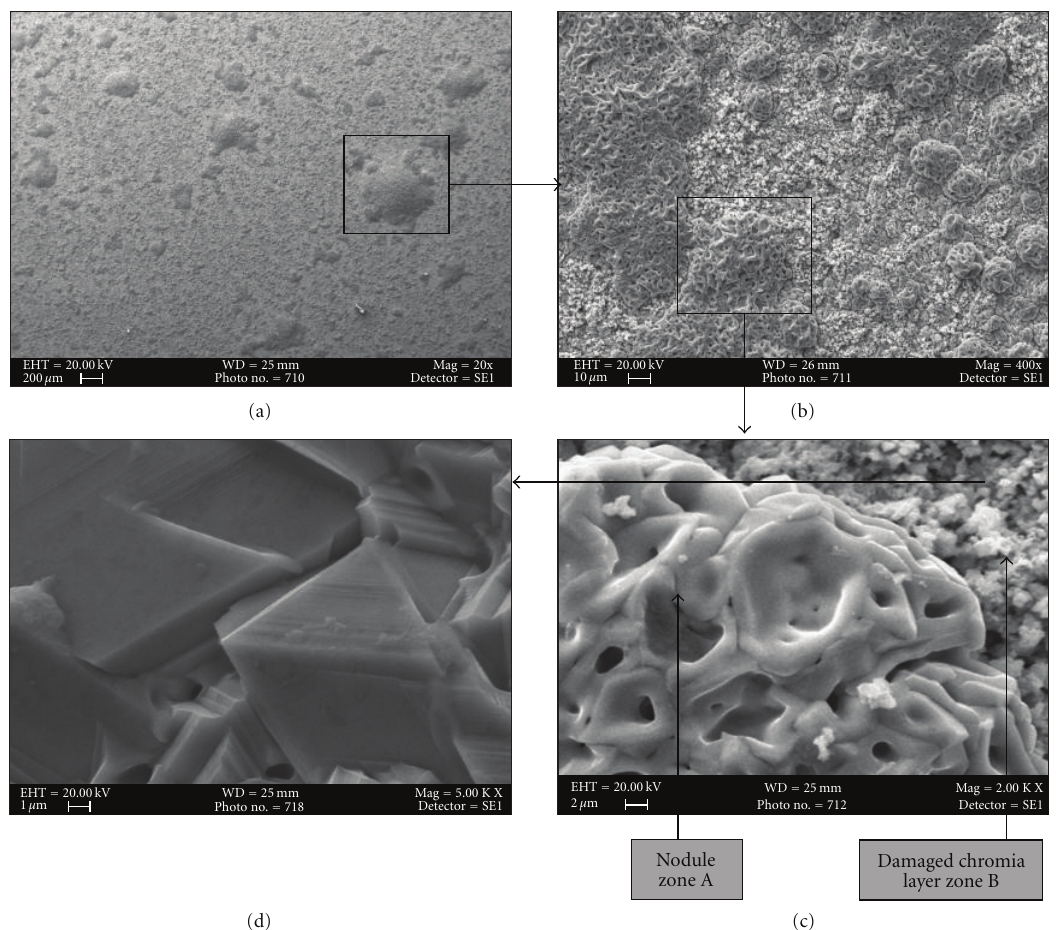
Figure 6: SEM micrograph of the surface of AISI 316 oxidized at 1000 ◦ C for 100 hours; (a) SEM image of the whole surface at magnification 20x, (b) SEM image at magnification 400x, (c) SEM image at magnification 2000x, and (d) SEM image at magnification 5000x the damaged chromia layer.